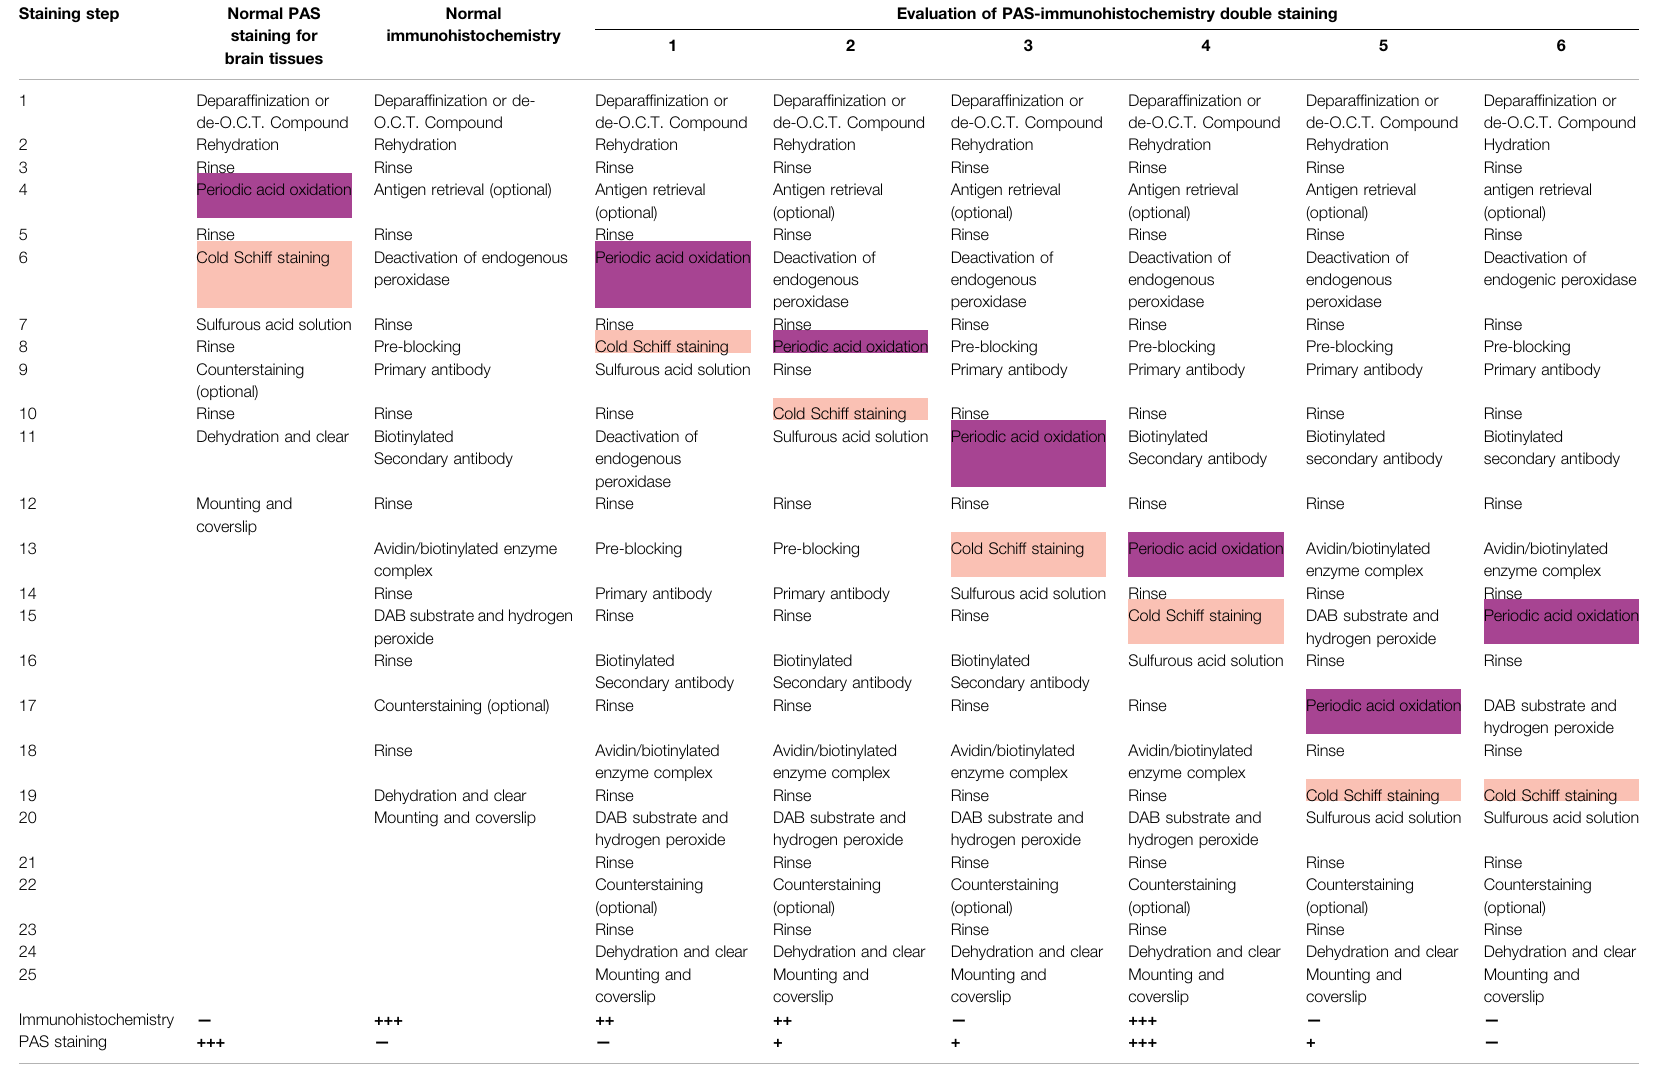
TABLE 1 | Examination of various methods of Periodic acid-Schiff and immunohistochemical double-staining and its staining results. Staining step